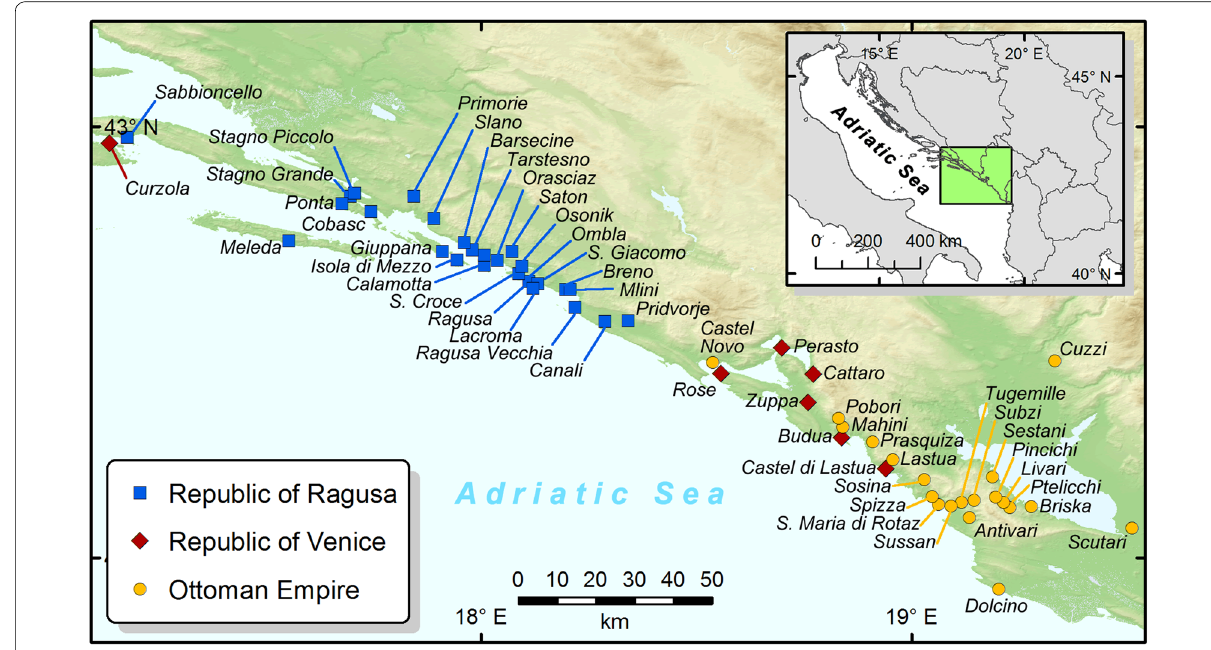
Fig. 1 Dalmatia and neighbouring areas around 1667, and places mentioned. The area was then ruled by three different countries, the Republic of Ragusa, the Republic of Venice, and the Ottoman